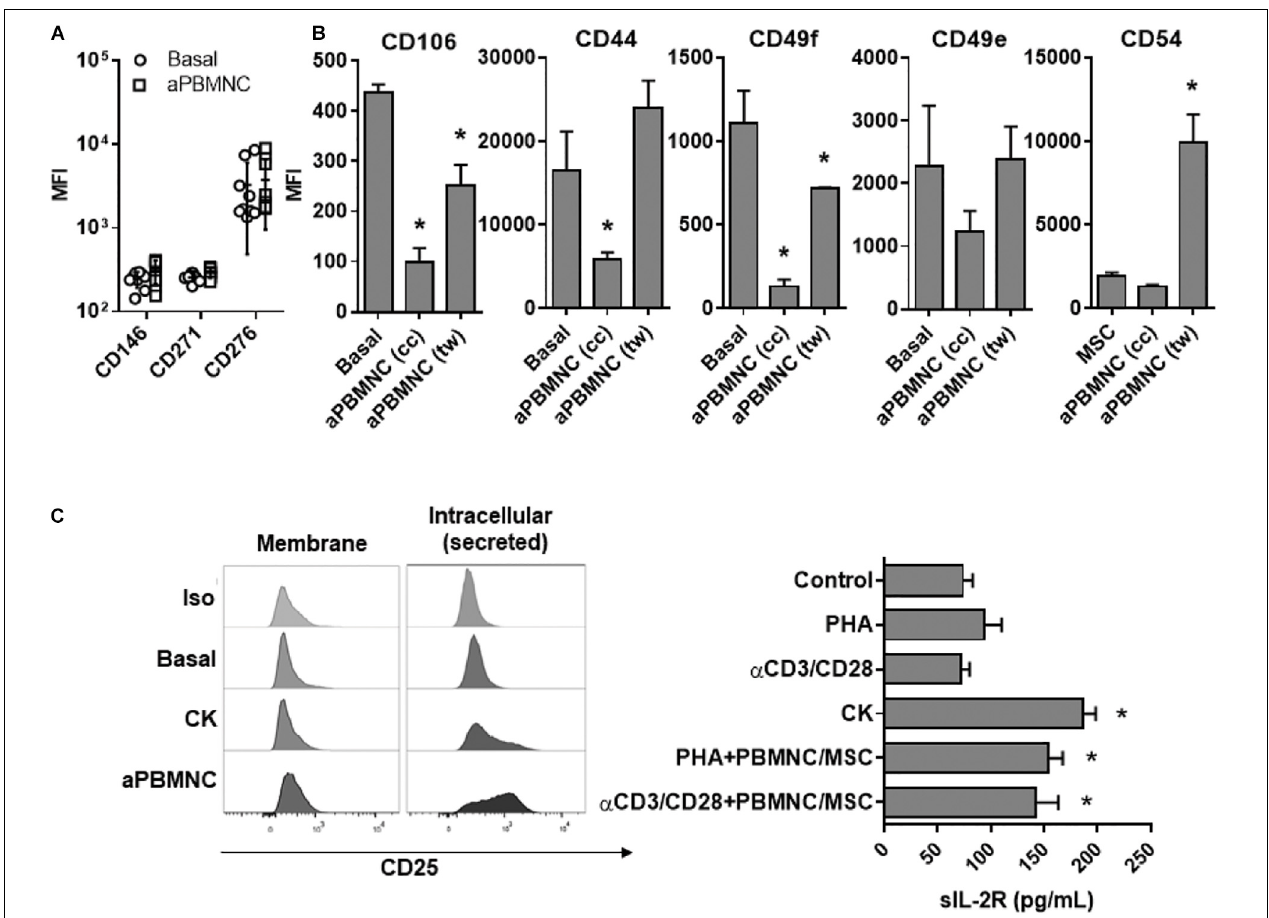
FIGURE 7 | Identification of novel functional markers of immune-modulatory UC.MSC. (A) Expression of CD146, CD271, and CD276 in UC-MSC under basal conditions or exposed to activated PBMNC for 5 days. (B) Expression of adhesion molecules CD106, CD54, CD44, CD49f, and CD49e in UC-MSC under basal conditions or exposed to activated PBMNC in cell contact (cc) or transwell (tw) setting for 5 days (* vs. Basal, p < 0.05, n = 4–6). (C) Detection of IL-2R in cell membrane, intracellular and in supernatants of UC-MSC treated with PHA, α CD3/CD28, TNF α /IL1b (CK), PHA and α CD3/CD28-activated PBMNC/MSC (* vs. Basal, p < 0.05, n =